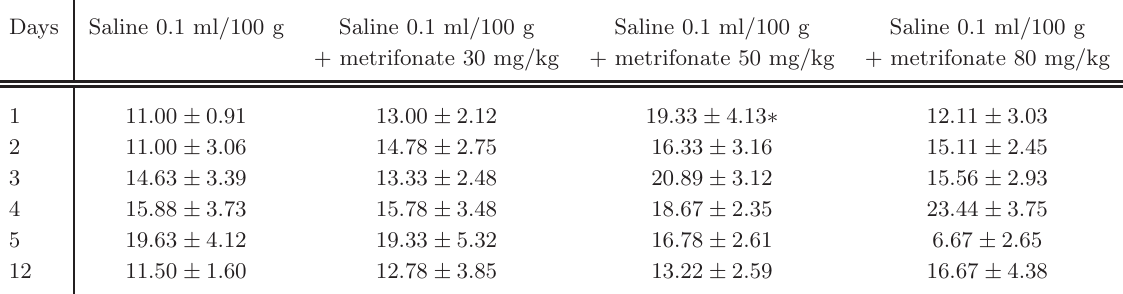
Table 2 Effects of metrifonate on active avoidance test (shuttle box): number of intertrial